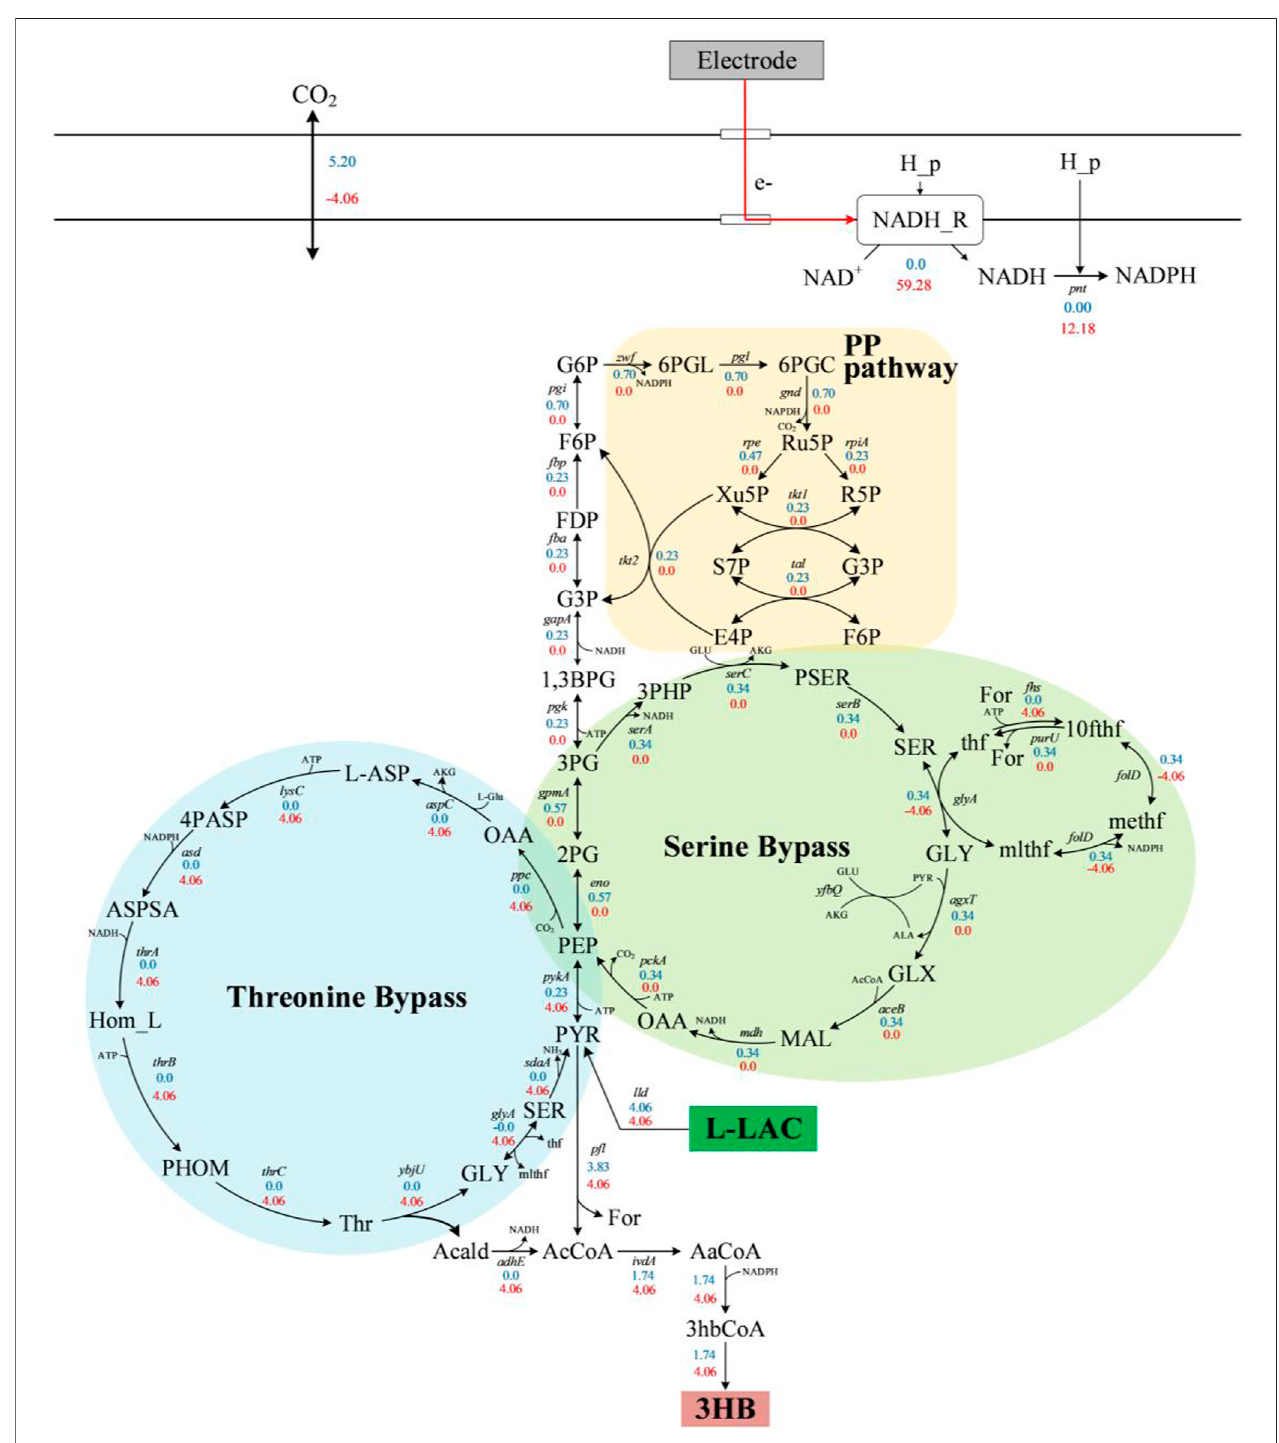
FIGURE9| Simulationresultsofthe fl uxdistributionfor3HBsynthesis.Blueorred fl uxesrepresentiLJ1162simulationresultswithoutorwithinwardelectrons.The blue module represents the threonine bypass, the green module represents the serine bypass and orange represents the pentose phosphate pathway. Abbreviation: For, formate; L-asp, L -aspartate; 4pasp, 4-phospho- L -aspartate; aspsa, L -aspartate 4-semialdehyde; hom_L, L -homoserine; phom, O-phospho- L -homoserine; Thr, L -threonine; acald, acetaldehyde; AaCoA, acetoacetyl-CoA; 3hbCoA, 3-hydroxybutanoyl-CoA.